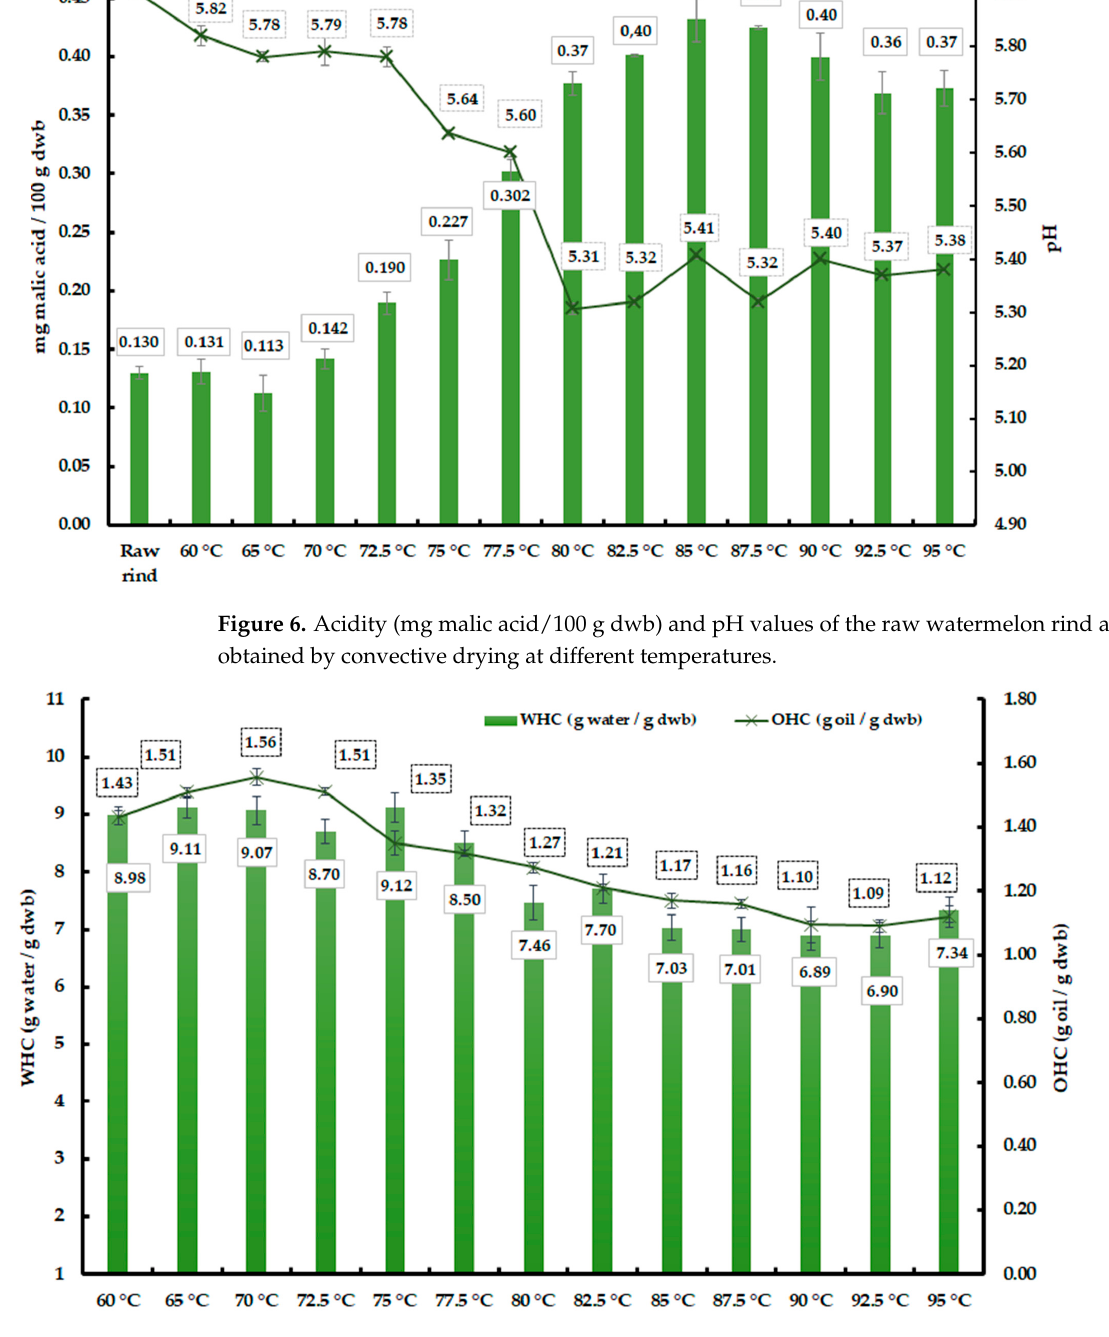
Figure 7 . WHC and OHC of flours obtained by convective drying at different temperatures. Figure 7. WHC and OHC of flours obtained by convective drying at different